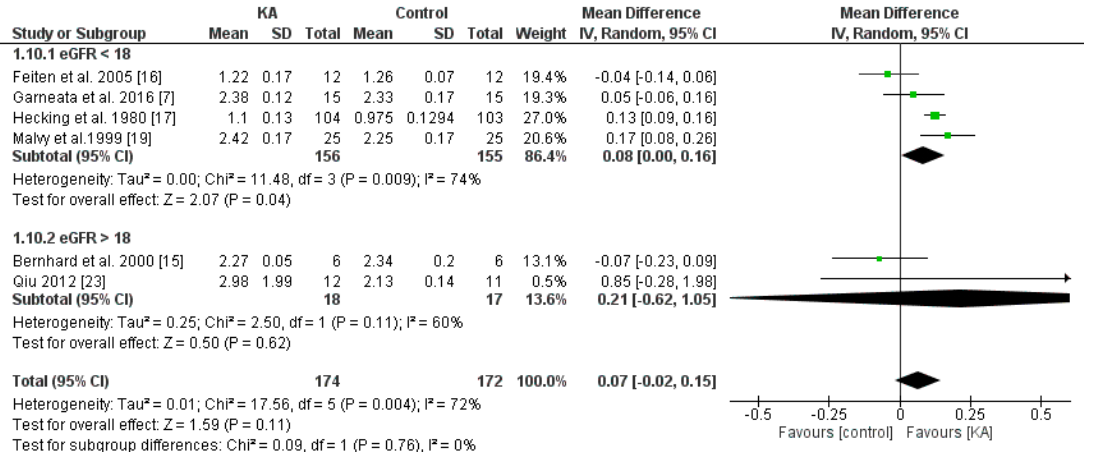
Figure 11. Forest plot of effects of KA on calcium in CKD patients sub-grouped by eGFR. The random-effects model was utilized.